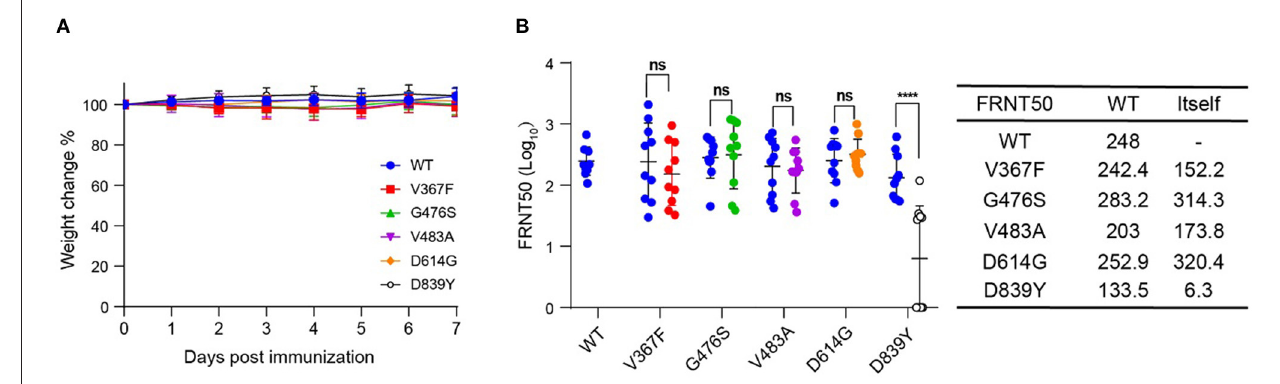
FIGURE 4 | Immunogenicity of SARS-CoV-2S variants. Groups of female hACE2 knock-in ICR mice ( n = 10) were vaccinated with a single dose of rVSV-SWT or variants via i.p. route (3 × 10 5 FFU/animal). (A) Following vaccination, weight changes were monitored for 7 days. (B) NAb titers against rVSV-SWT or the same variants were determined by FRNT and calculated by the Reed-Muench method at 30 days post-vaccination. Group geometric mean titers (GMTs) were indicated. Error bars indicate SD ( n = 3). The result is representative of three independent experiments. i.p. injection of 1 × 10 6 FFU of rVSVs ( Figure 6A ).